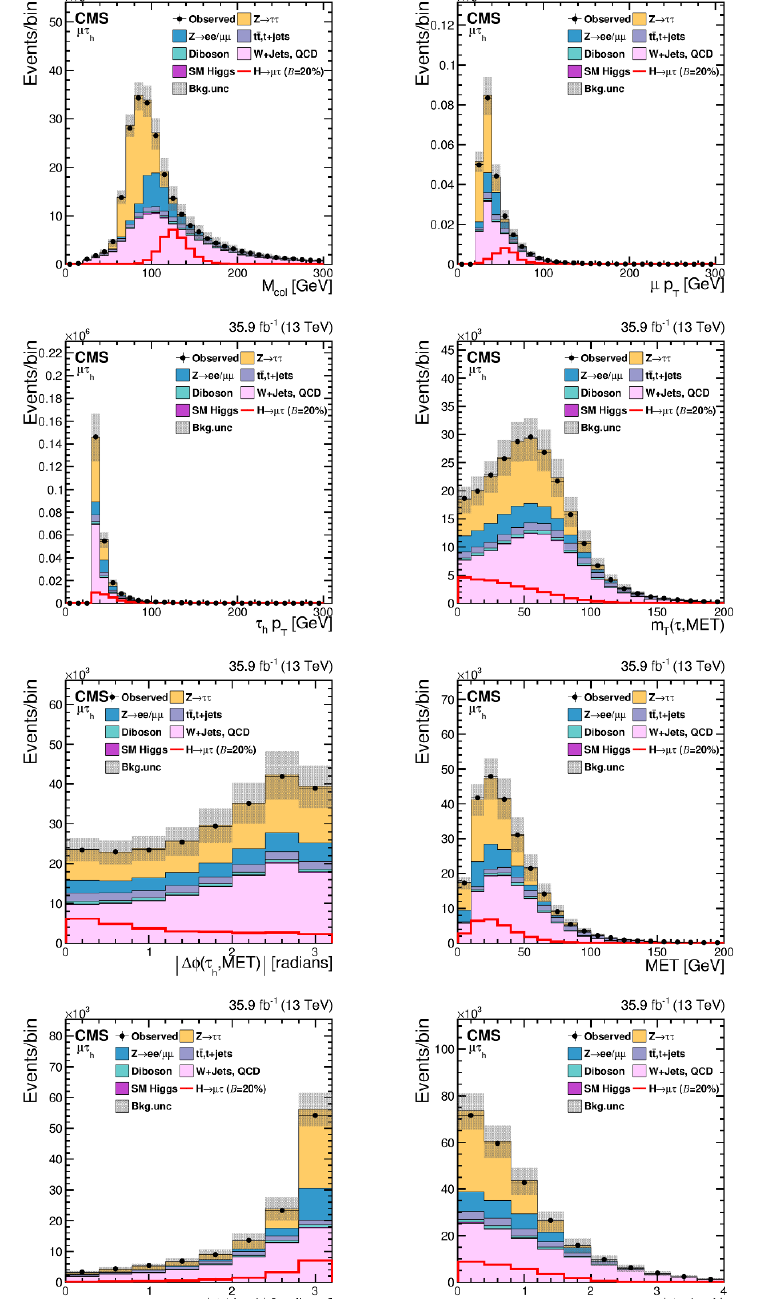
Figure 1 . Distributions of the input variables to the BDT for the H ! (cid:22)(cid:28) h channel. The back- ground from SM Higgs boson production is small and not visible in the plots.